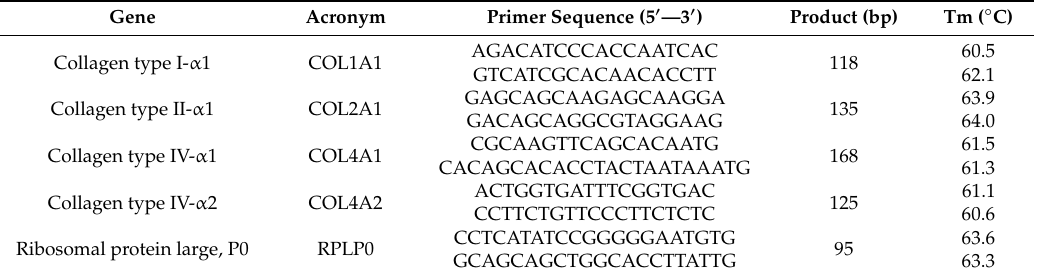
Table 1. Analyzed genes involved in di ff erentiation of mesenchymal stem cells (MSCs) toward tympanic membrane (TM) fibroblast phenotype seeded on star-branched poly( ε -caprolactone) (*PCL) sca ff olds; primer sequence for RPLP0 housekeeping gene, product base pair and applied temperature